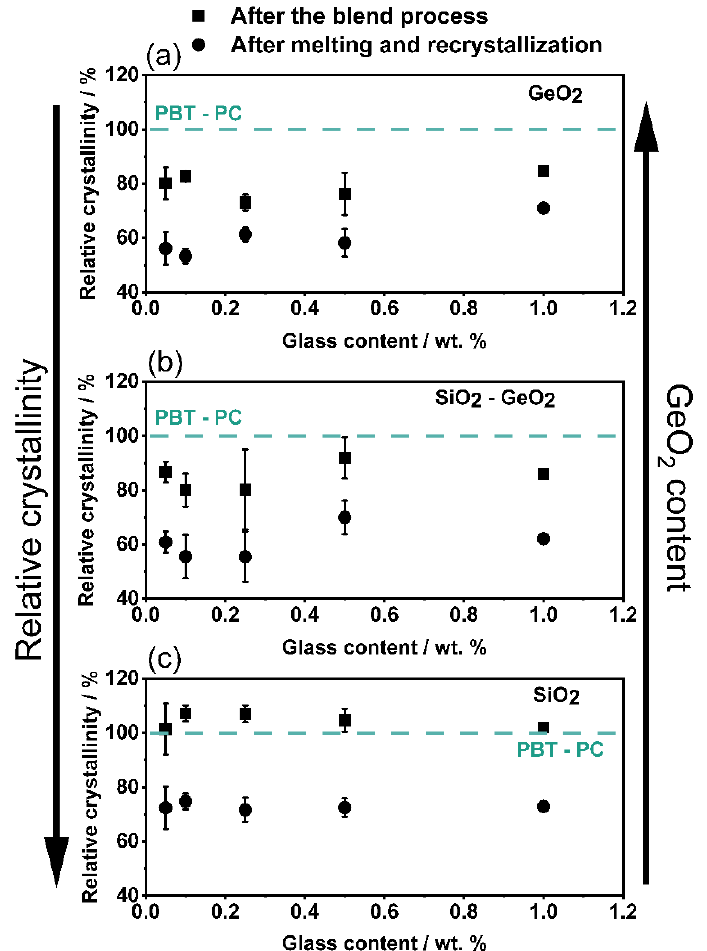
Figure 13. Influence of the glass content on the relative crystallinity of the PBT ‐ PC composite. ( a ) GeO 2 ; ( b ) SiO 2 ‐ GeO 2 ; ( c ) SiO 2.